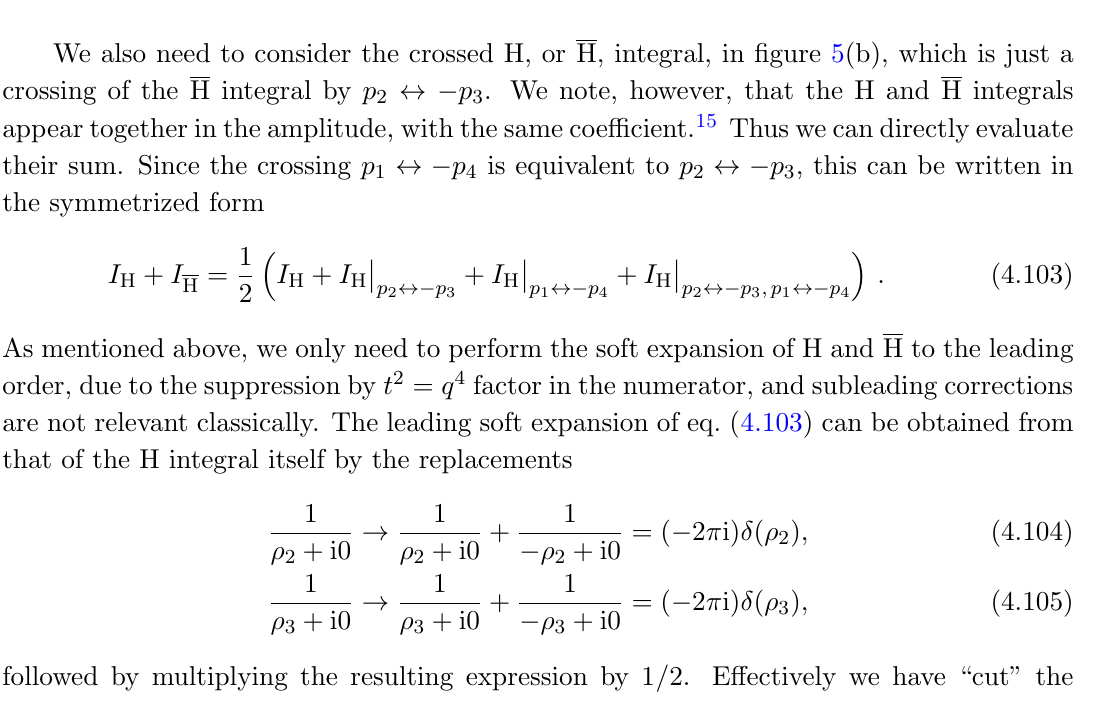
Figure 14. Topologies relevant for the H master